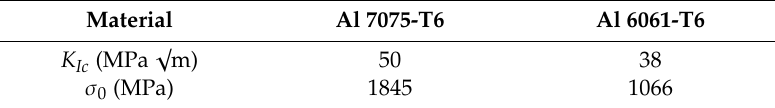
Table 2. Material properties implemented in the present